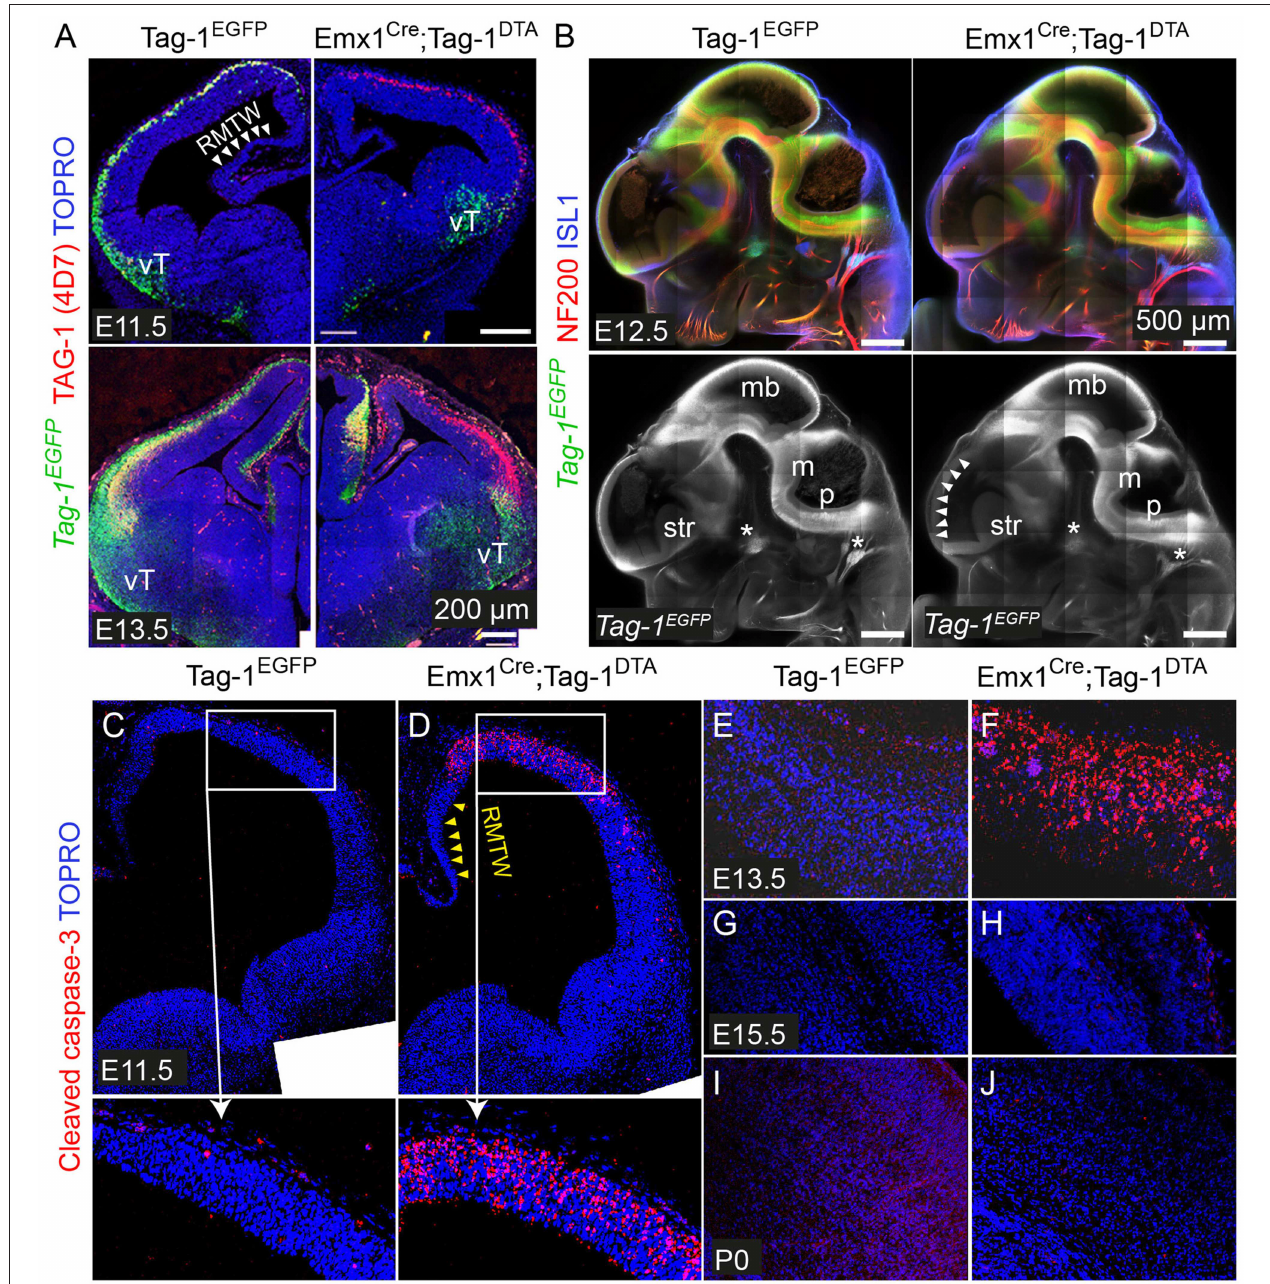
FIGURE 4 | Emx1 Cre -mediated recombination in Tag-1 loxP − EGFP − loxP − DTA embryos results in EGFP removal and neocortical cell death during stages E11.5 to E13.5. (A) Immunofluorescence against EGFP and TAG-1 in in Tag-1 EGFP and Emx1 Cre ;Tag-1 DTA mice at E11.5 and E13.5. Note the lack of recombination at the ventral telencephalon (vT). (B) Whole mount immunofluorescence against EGFP, neurofilaments and ISL1 in control and double transgenic mice at E12.5 shows the selective EGFP switch-off in the dorsal telencephalon (see white arrowheads). Note that sensory ganglia (ISL1 + , shown by asterisks) remain unaffected upon Emx1 Cre -mediated recombination. (C–J) Immunofluorescence against cleaved caspase-3 (reflecting cell death) in in Tag-1 EGFP and Emx1 Cre ;Tag-1 DTA mice at E11.5 to P0. RMTW, rostromedial telencephalic wall, vT, ventral telencephalon, mb, midbrain, m, medulla, p, pons, str, striatum.